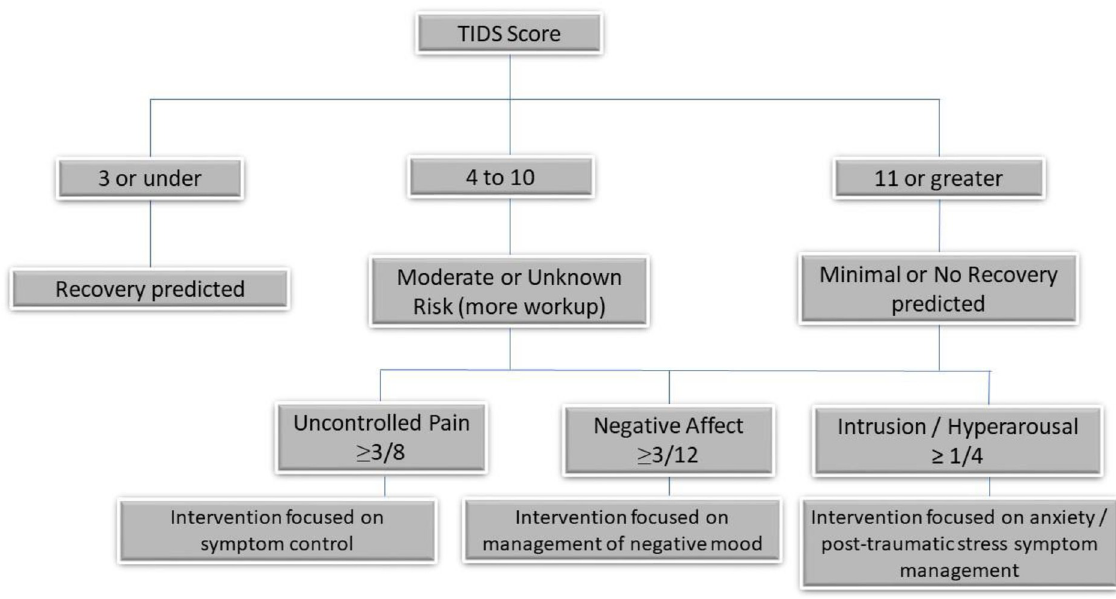
Fig 1. Clinical decision-making aid based on the theoretical foundations of each TIDS subscale.